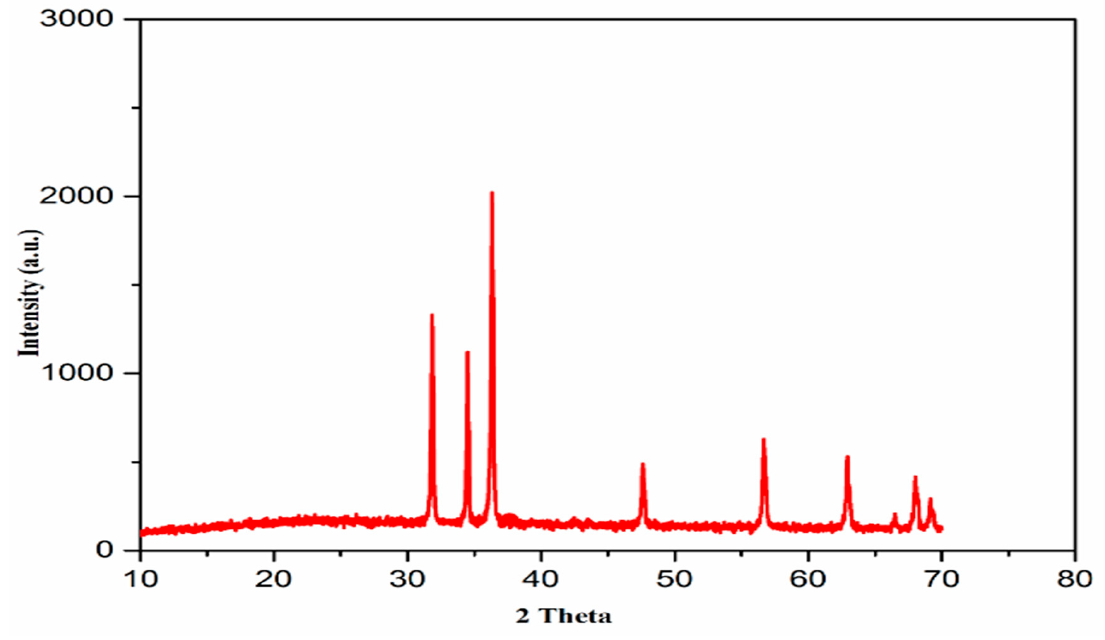
Figure 3. XRD patterns of MB-ZnO nanocomposites.